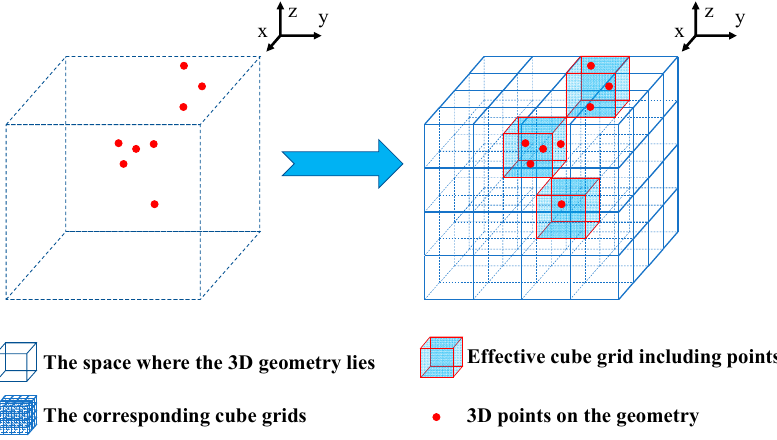
Figure 5. Diagram of the process for dividing the 3-D space in which the target lies into corresponding cube grids.